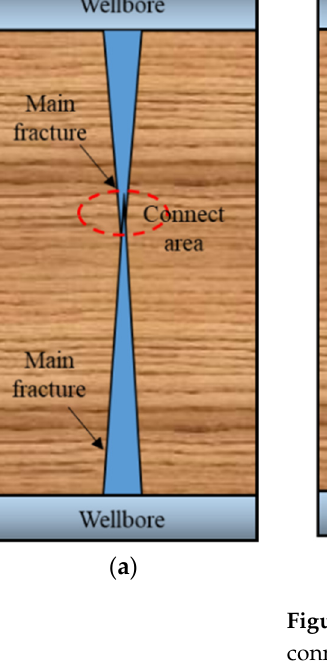
Table 4. The fracture connectivity characterized by the half-life time.